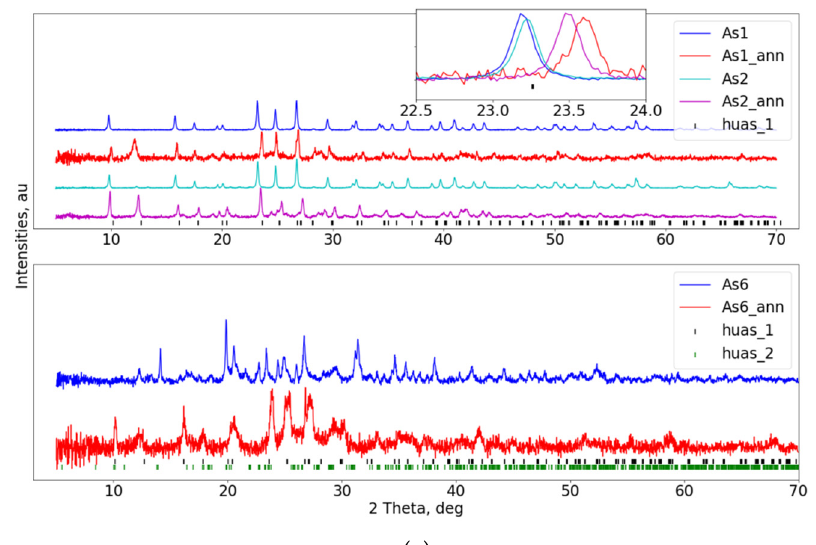
Figure 2. Diffractograms of raw HUAs (UO 2 )(HAsO 4 )(H 2 O) 4 and HUP (UO 2 )(HPO 4 )(H 2 O) 4 ma- terials in the upper and lower sub-figures, respectively. Curves show results obtained before ( blue ) and after ( red ) annealing. Vertical bars indicate reflections’ positions of assigned crystallographic phases (see main text).